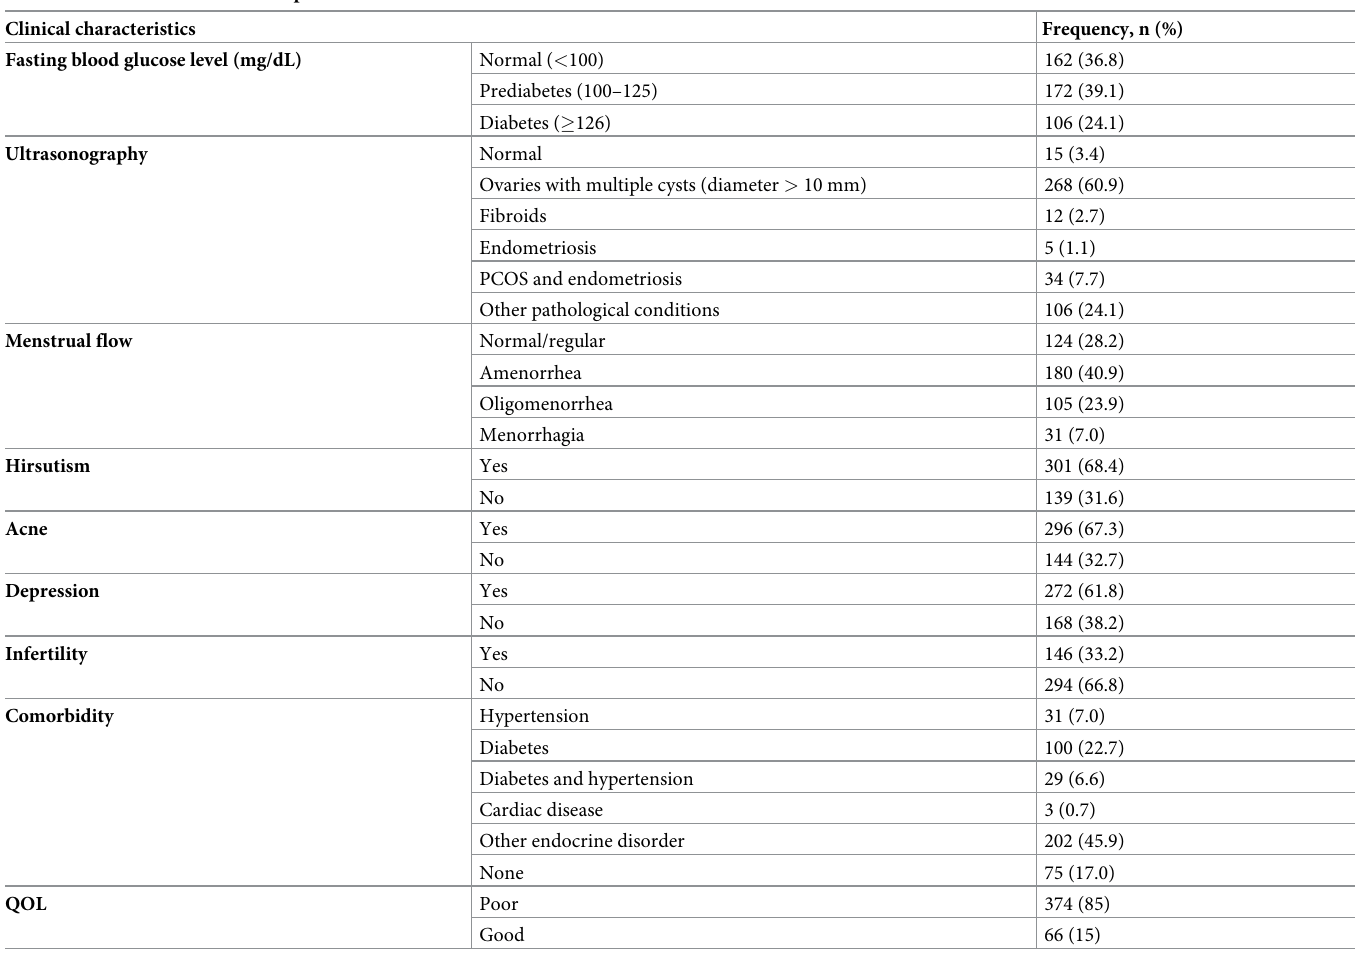
Table 2. Clinical characteristics of patients with